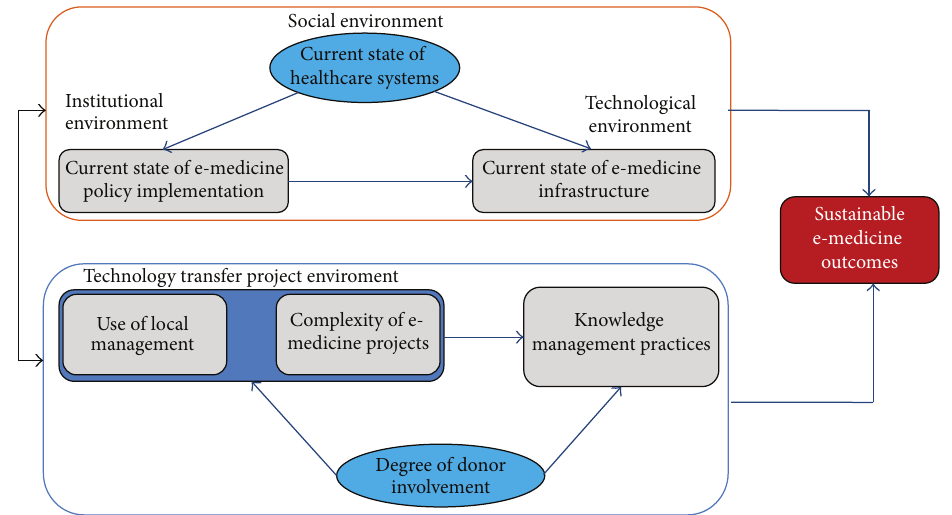
Figure 1: Hypothetical structural model for e-medicine